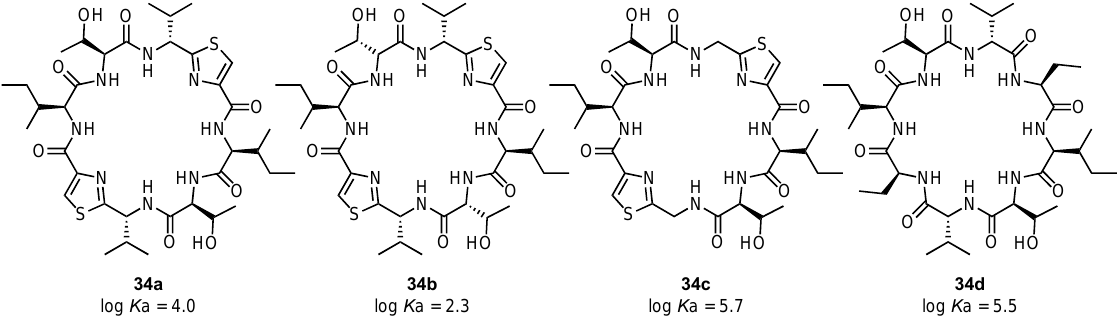
Figure 17. Structures of cyclopeptides 35a – g , 36 , and 37 ( a ), and crystal structures of 35a (CSD Entry: LUBKEY) ( b ), 35b (CSD Entry: HAHNEK) ( c ), and 36 (CSD Entry: XIBDES) ( d ). Solvent molecules, and protons, except acidic ones, are omitted for reasons of clarity.